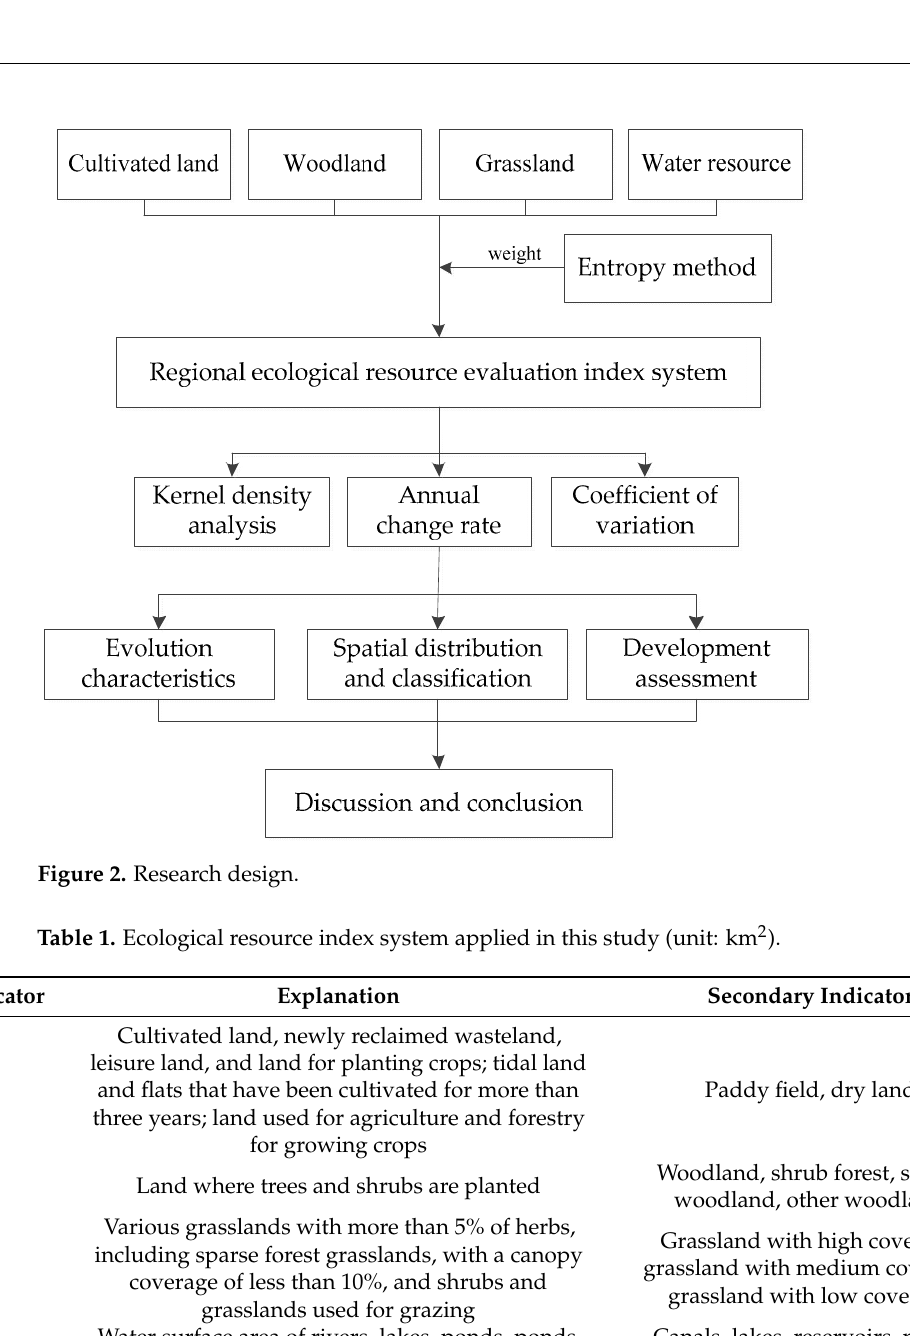
Table 1. Ecological resource index system applied in this study (unit: km 2 ).